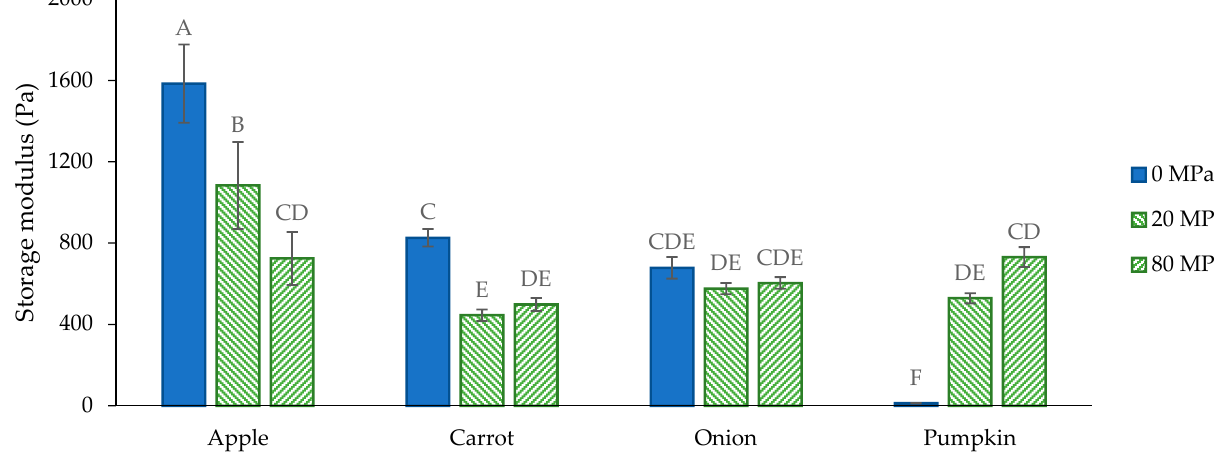
Figure 6. Storage modulus (G ′ ) of the suspensions (2% w / w ) prepared with the acid-unextractable fraction of apple, carrot, onion and pumpkin before (0 MPa) and after high-pressure homogenization at 20 and 80 MPa at 10 rad/s angular frequency and 0.1% strain; data are from the frequency sweep. The error bars represent the standard deviation ( n = 2 × 2) and significant differences are indicated by different letters (Tukey test, p < 0.05).